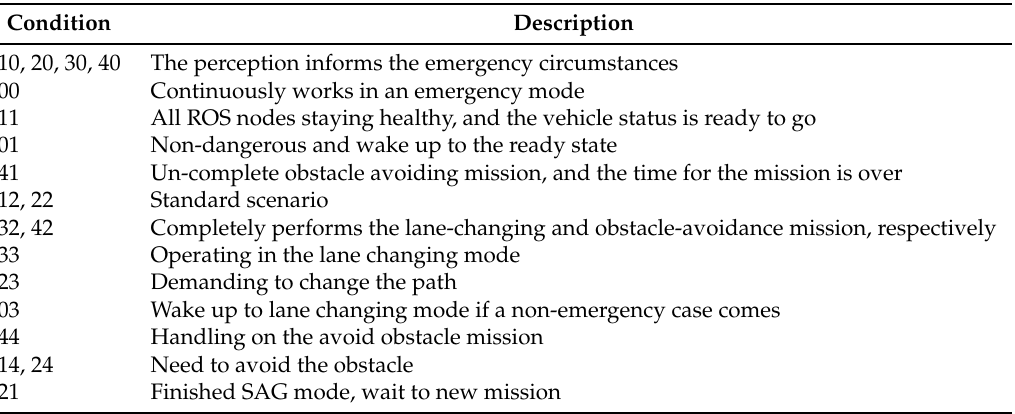
Table 1. The descriptions of transition conditions of Decision-Making Mechanism (DMM).